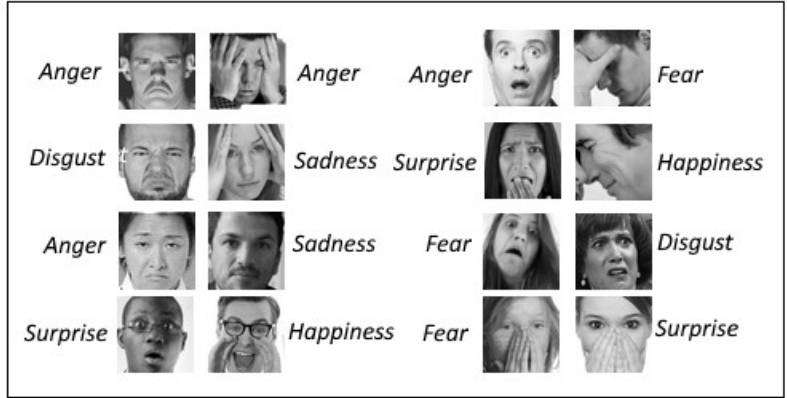
Figure 4. Some emotions from the Kaggle Dataset.